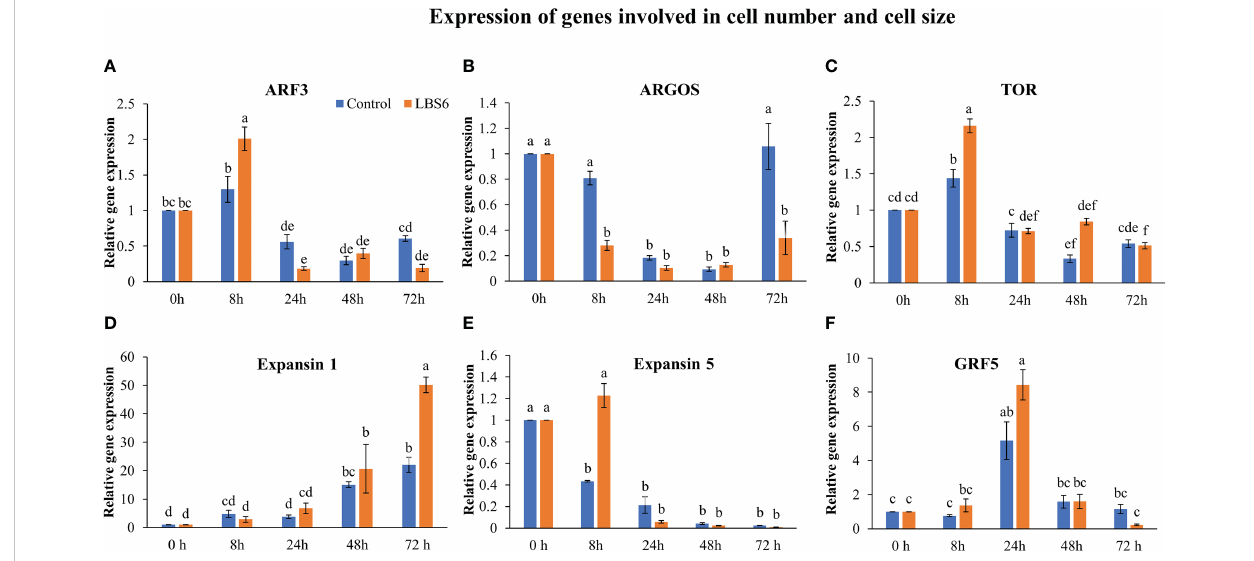
FIGURE 5 LBS6 regulated the expression of (A) ARF3 , (B) ARGOS , (C) TOR , (D) Expansin 1 , (E) Expansin 5 , and (F) GRF5 involved in cell size, and cell expansion. The values in the graph represents the relative gene expression. The values were presented as mean ± SE of three independent replicates, and signi fi cantly different mean values were represented by different